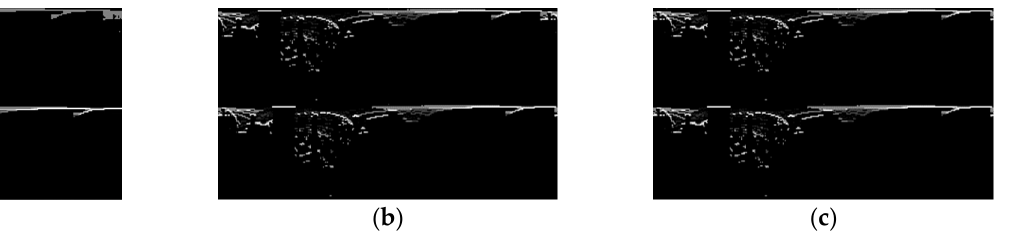
Figure 9. A circular expansion of the point cloud alignment results. ( a ) Original source and target point clouds. ( b ) Alignment results using ICP algorithm. ( c ) Alignment results using our algorithm.